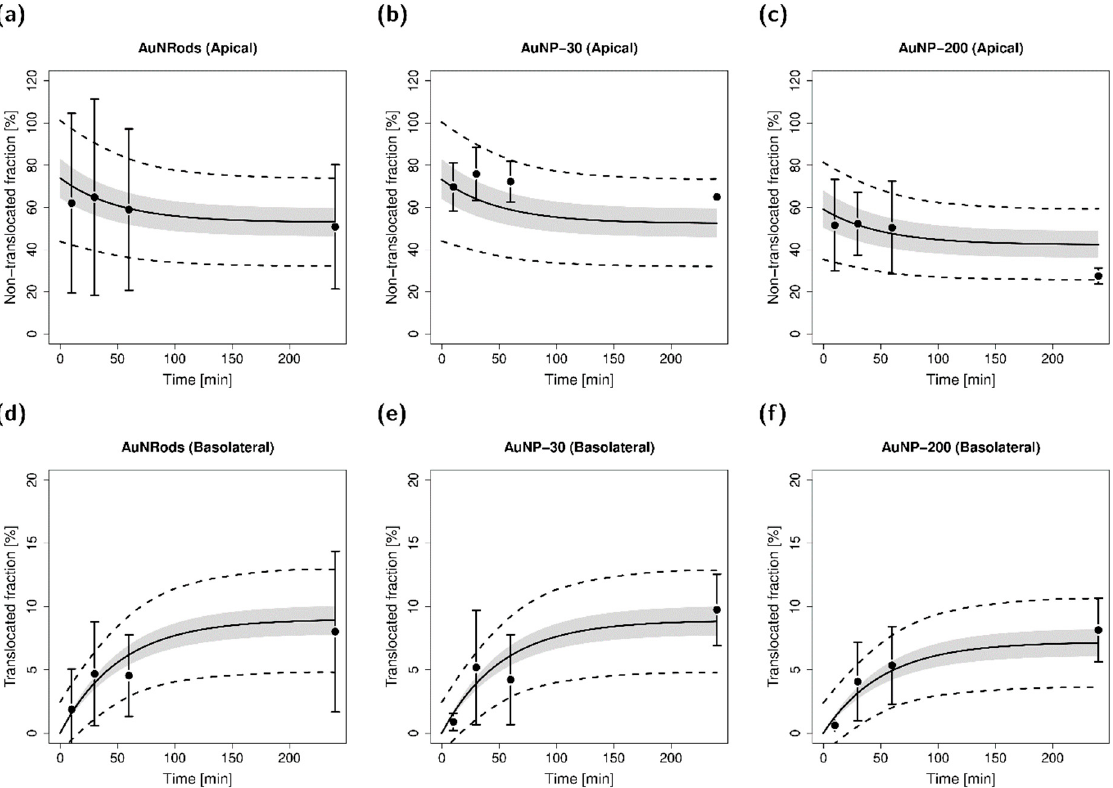
Figure 5. Disposition of AuNRods, AuNP-30 and AuNP-200 in the apical ( a – c ) and basolateral ( d – f ) compartment, respectively. Observed fractions of applied particles are depicted as circles (arithmetic mean and standard deviation). Model simulation means are shown as lines. Shaded areas depict the 95% confidence interval; dashed lines depict the upper and lower limit of the 68% prediction interval.